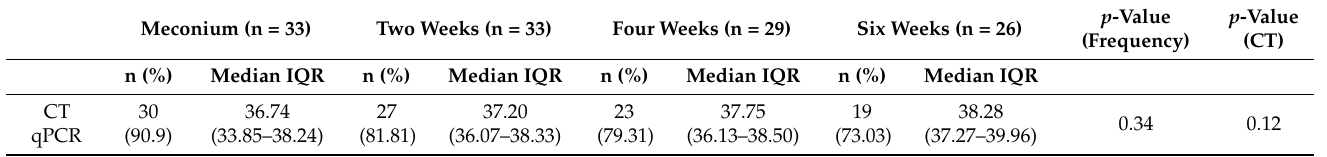
Table 4. Result of the detection of methanogenic Archaea.